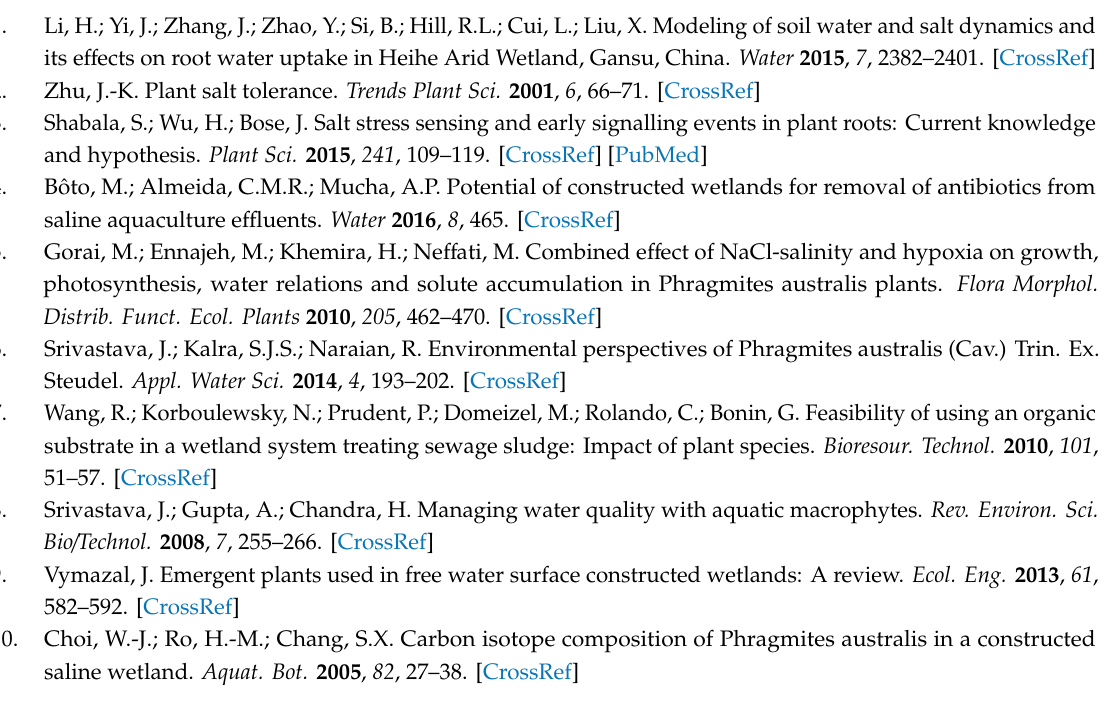
Figure S1: Spring buds of P. australis Sampling site in wetland of Daxing District, Beijing, Figure S2: Changes of amino acids in di ff erent treatments in each period. Defined the highest in each row as 100%, the rest of each row is converted to percentage by relative value, Figure S3: Changes of amino acids in di ff erent treatments throughout all the experimental period. Defined the highest in each row as 100%, the rest of each row is converted to percentage by relative value, Table S1: The recovery rate of NaCl remove procedure, Table S2: The gradient elution process of amino acid mobile phase A and B, Table S3: The HPLC elution time for amino acids, Table S4: The calibration curve for each kind of amino acid and relative standard deviation (RSD), Table S5: Content of total free amino acids (TotAA) and single compounds (absolute content) of root exudates of Phragmites australis clones (stress time 1, 2, 4h) compares for five NaCl-salinity